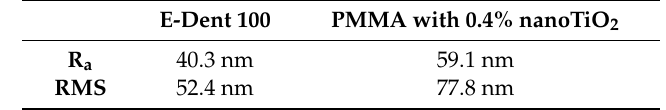
Table 1. Statistical quantities calculated for the 2D topography image (10 × 10 µ m).